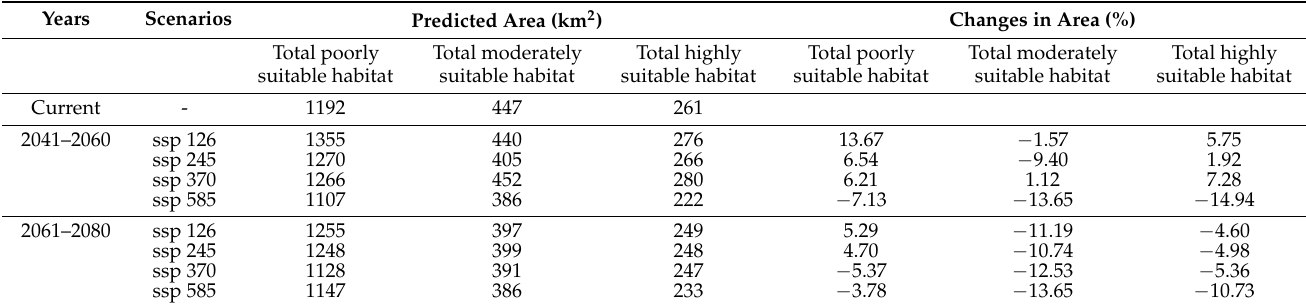
Table 3. Extent of predicted three different categories of suitable habitats (km 2 ) for Boreal Owl ( Aegolius funereus ) in current time, and in two periods: 2041–2060 and 2061–2080, in different climate scenarios (SSP 126, 245, 370, 585). Additionally, we calculated changes (%) from current time to future periods.